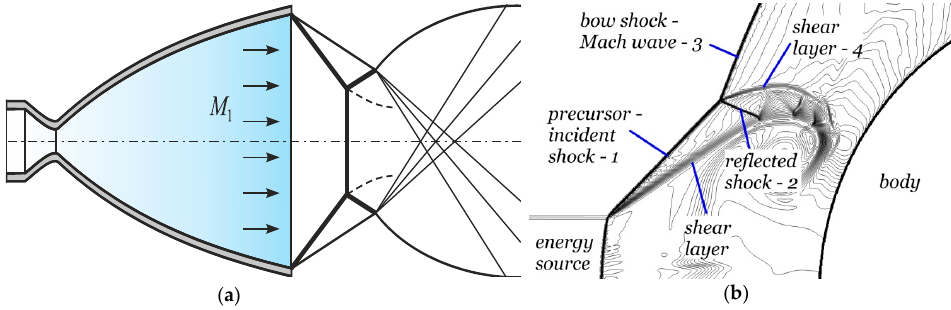
Figure 3. ( a ) Steady three shock wave configuration at the outlet of the nozzle, simple Mach